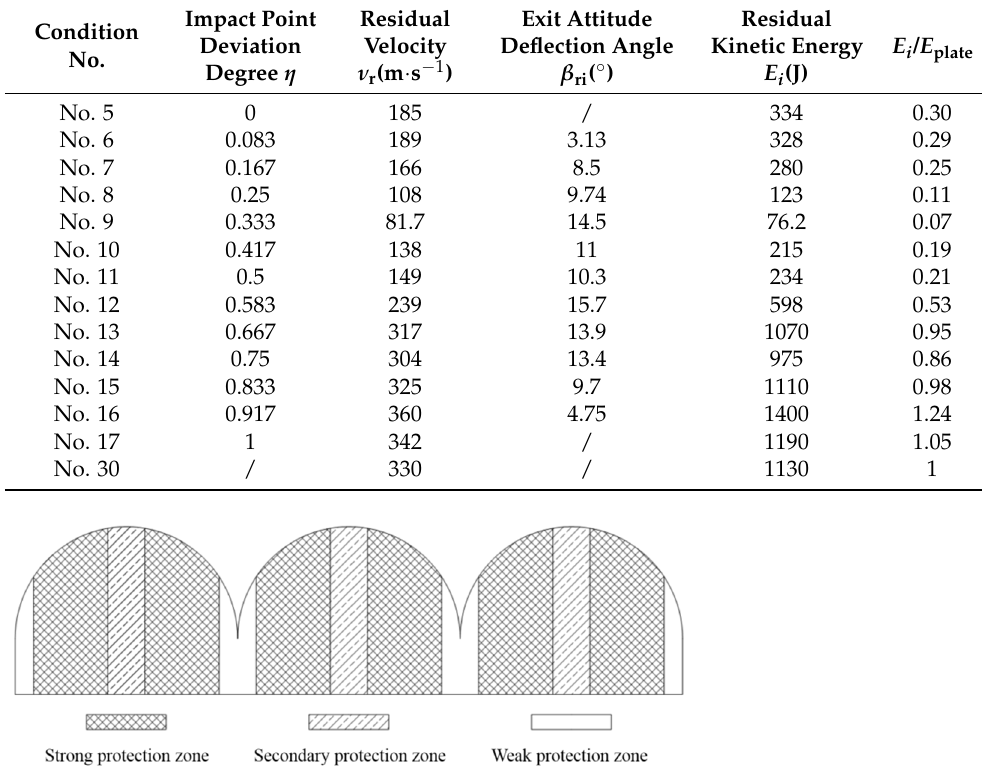
Figure 20. Area division of specially shaped ceramic composite armor.